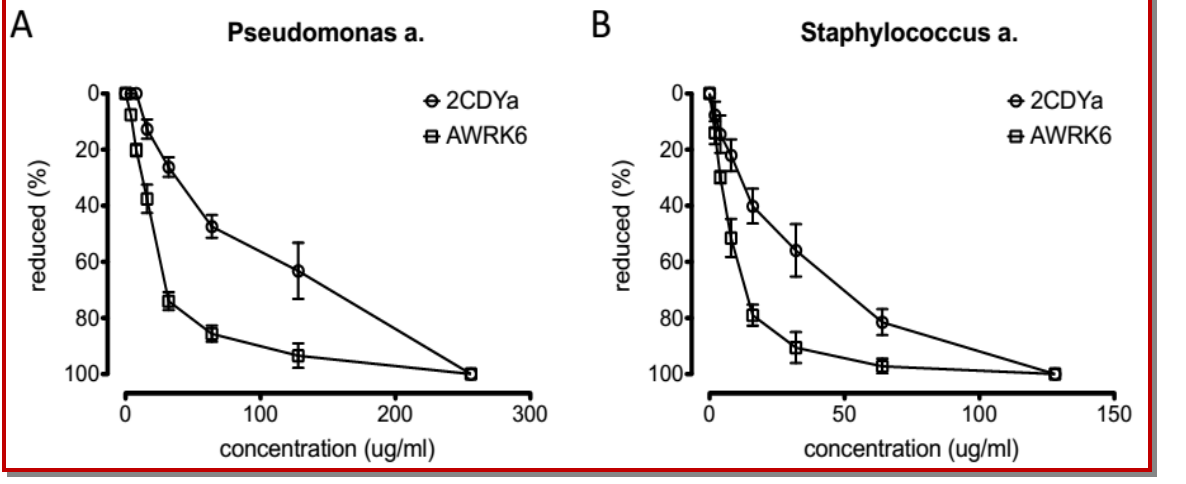
Figure 3: Time-dependent inhibition of bacterial growth by Dy2 or AWRK6 A. P. aeruginosa was incubated with 128 μ g/mL of either Dy2 or AWRK6 for the indicated time intervals (0-3 hours). B. S. aureus was incubated with 64 μ g/mL of either Dy2 or AWRK6 for the indicated time intervals. Samples were collected at the indicated time and their CFUs were determined. Data are the means ± SEMs from four